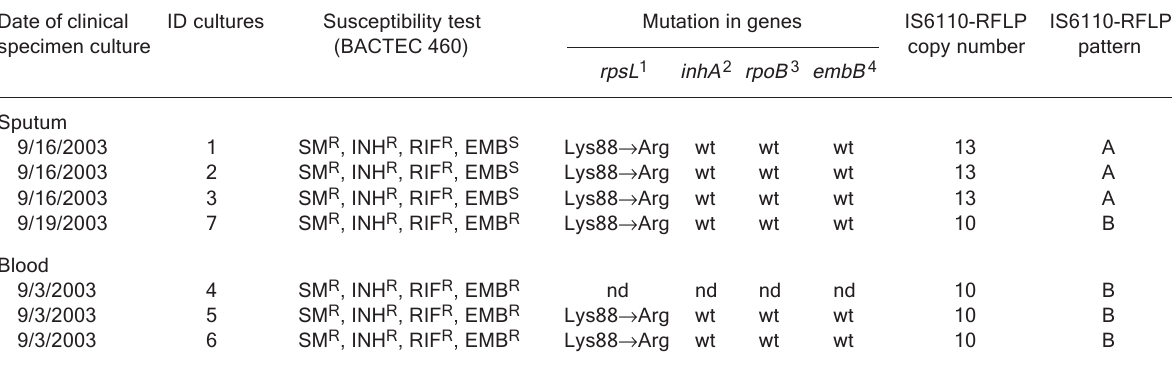
Table 1. Molecular typing and drug susceptibility (phenotypic and genotypic profile) of multiple blood and sputum isolates from the same patient with pulmonary and disseminated